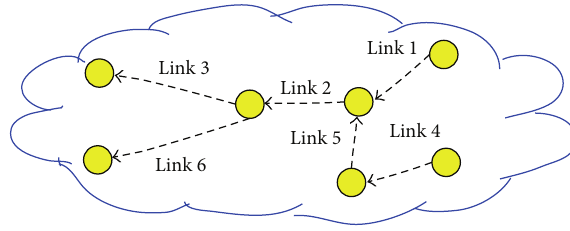
Figure 4: A wireless multihop sensor network.